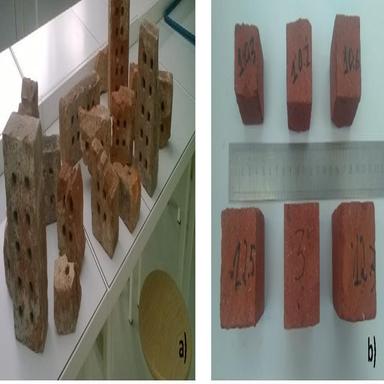
Raw perforated clay bricks a) and samples b) from the former spinning factory Dollfus, Mieg and Cie - bricks dating back to the 19200 s.